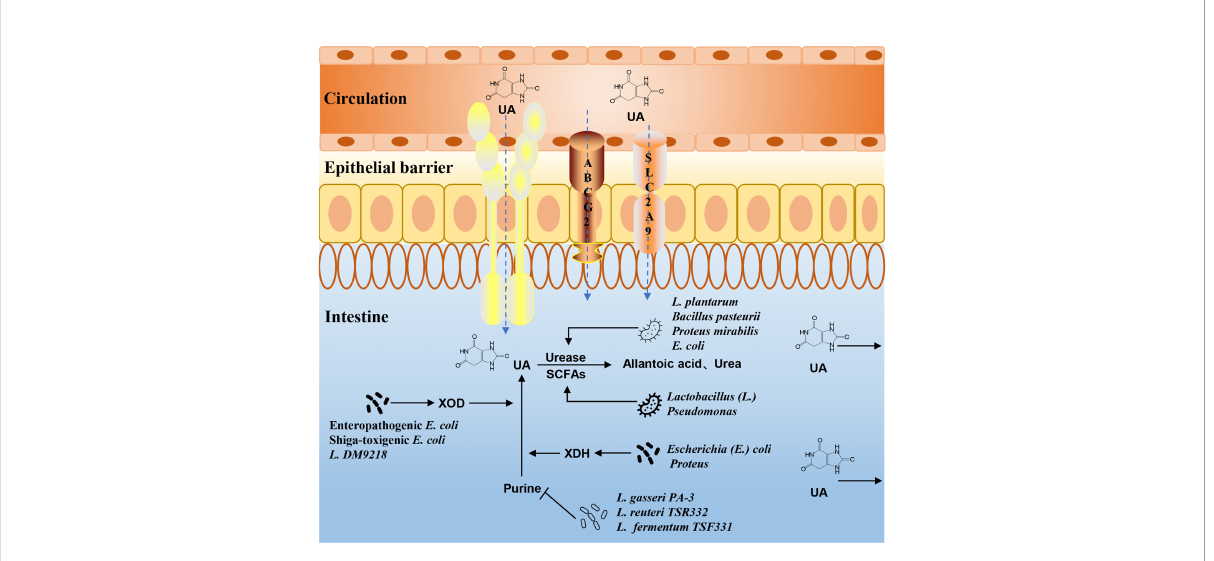
FIGURE 3 The mechanism of gut microbiota in UA and purine metabolism. The intestinal fl ora can affect purine metabolism, XOD, XDH, and urease activities, or the composition of SCFAs, and then alter the production and excretion of